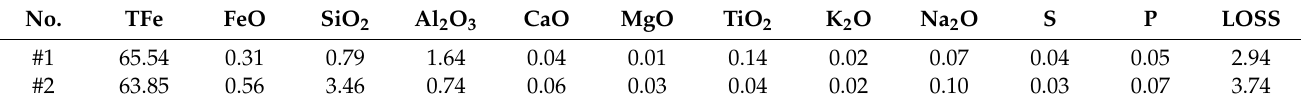
Table 1. Chemical composition of iron ore raw materials (wt